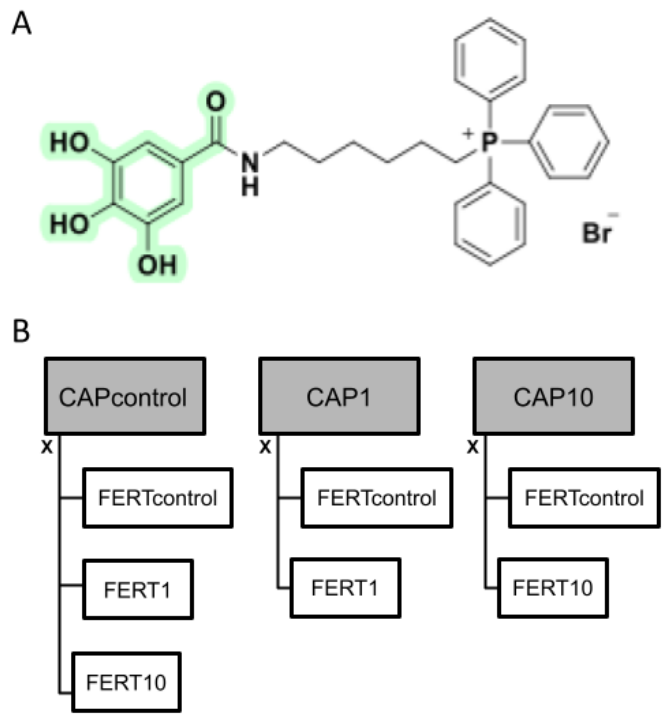
Figure 1. ( A ) Chemical structure of the hydroxybenzoic acid mitochondria-directed AntiOxBEN2 and ( B ) experimental design. To evaluate the effect of AntiOxBEN2 on bovine sperm capacitation and fertilization processes, this molecule was added to the capacitation (CAP) and/or to the fertilization (FERT) media, at the concentration of 0 (control), 1, and 10 µM, giving rise to seven groups. CAPcontrol: capacitation medium without supplementation; CAP1: capacitation medium supplemented with 1 µM of AntiOxBEN2; CAP10: capacitation medium supplemented with 10 µM of AntiOxBEN2; FERTcontrol: fertilization medium without supplementation; FERT1: fertilization medium supplemented with 1 µM of AntiOxBEN2; FERT10: fertilization medium supplemented with 10 µM of AntiOxBEN2.